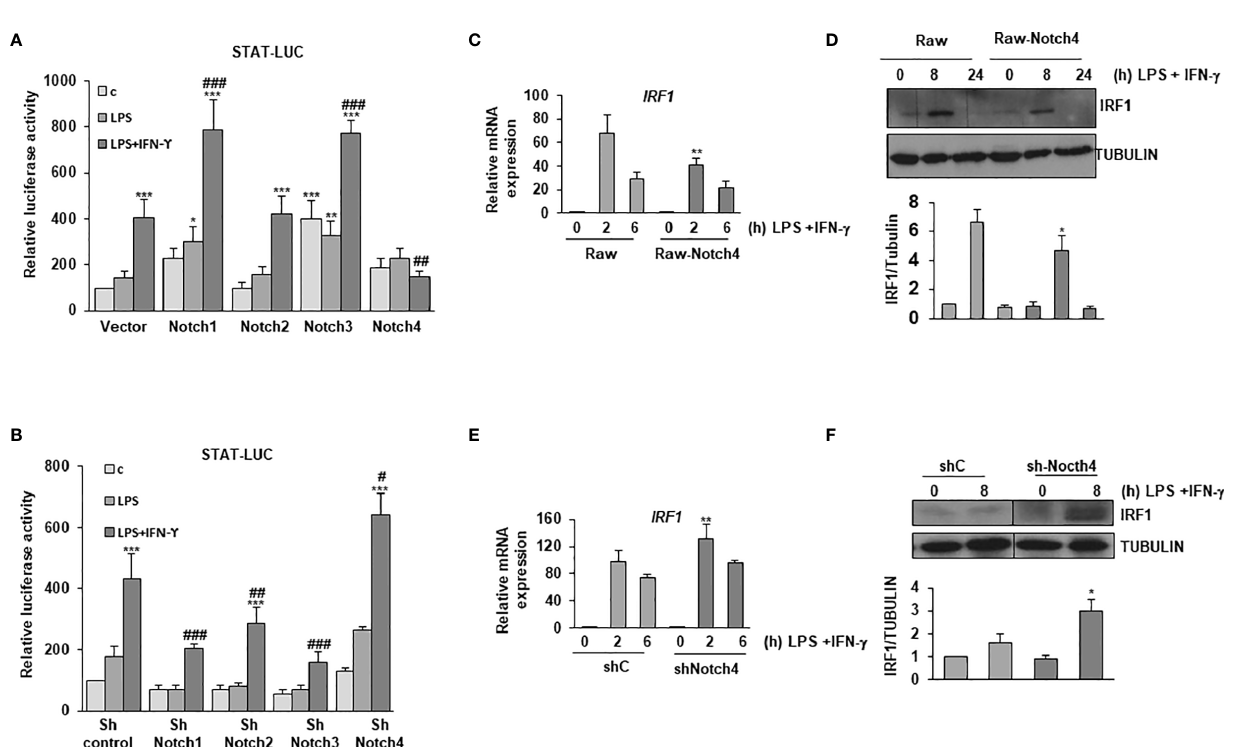
FIGURE 3 | Effect of NOTCH4 expression on the response of LPS-activated macrophages to IFN- g . Analysis of the luciferase activity in Raw 264.7 cells transiently transfected with a STAT-luciferase reporter (STAT-luc) and (A) different Notch receptor expression vectors or the corresponding empty vector or (B) with speci fi c shRNAs for the different Notch receptor genes or control shRNA. One day after transfection, cells were stimulated with LPS (100 ng/ml) and IFN- g (10 U/ml) for 24 h before analysis. The means ± SD of three independent experiments are shown. One-way ANOVA/Bonferroni ’ s post-tests were performed. *p<0.05, **p<0.01 and ***p<0.001, compared to the control transfected cells. # p<0.05, ## p<0.01, ### p<0.001, compared to LPS and IFN- g treated control transfected cells. (C) Quantitative PCR and (D) Western blot analysis of IRF1 expression in Raw 264.7 cells transfected with a Notch4 expression vector or the corresponding empty vector for 24 hours and activated for different times with LPS and IFN- g . RNA expression was referred to that of the P0 housekeeping gene used as a control. Protein levels were referred to the tubulin loading control. Quantitation of three different experiments is shown. One-way ANOVA/Bonferroni ’ s post-tests were performed. *p<0.05, **p<0.01, compared to the corresponding treatment of the empty vector transfected cells. (E) Quantitative PCR and (F) Western blot analysis of IRF1 expression in Raw 264.7 cells transfected with speci fi c shRNA for Notch4 gene or control shRNA for 24 hours and activated for different times with LPS and IFN- g . RNA expression was referred to that of the P0 gene. Protein levels were referred to tubulin loading control. Quantitation of three different experiments is shown. One-way ANOVA/Bonferroni ’ s post-tests were performed. *p<0.05, **p<0.01, compared to the corresponding treatment of the scrambled